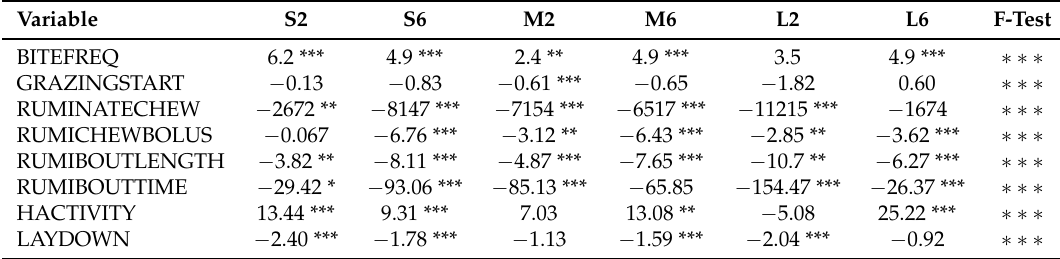
Table A3. ANOVA F-test and multiple comparisons tests for the blocks of 60% and 100% herbage allowance groups using each predictor of the combined data.